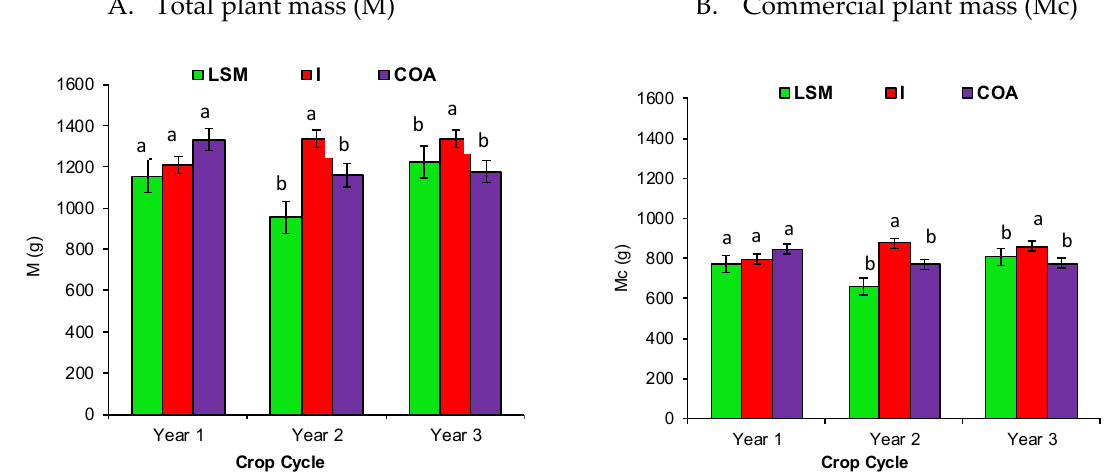
Figure 2. ( A ). Total plant mass (M) and ( B ). commercial plant mass (Mc) of the celery crop, as a function of the fertilization treatment: local sheep manure (LSM), inorganic treatment (I), and commercial organic amendment (COA). “a” and “b” indicate significant differences between the three years of each treatment at the 95% confidence level.